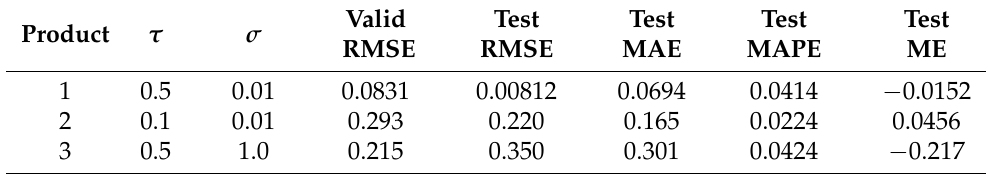
Table 6. Prophet results: RMSE on the validation set, RMSE, MAE, MAPE and ME calculated on the test set. The metrics were calculated as described in the main text. Please note that the MAPE is computed for the price times series p t , not for the ∆ ( t ) time